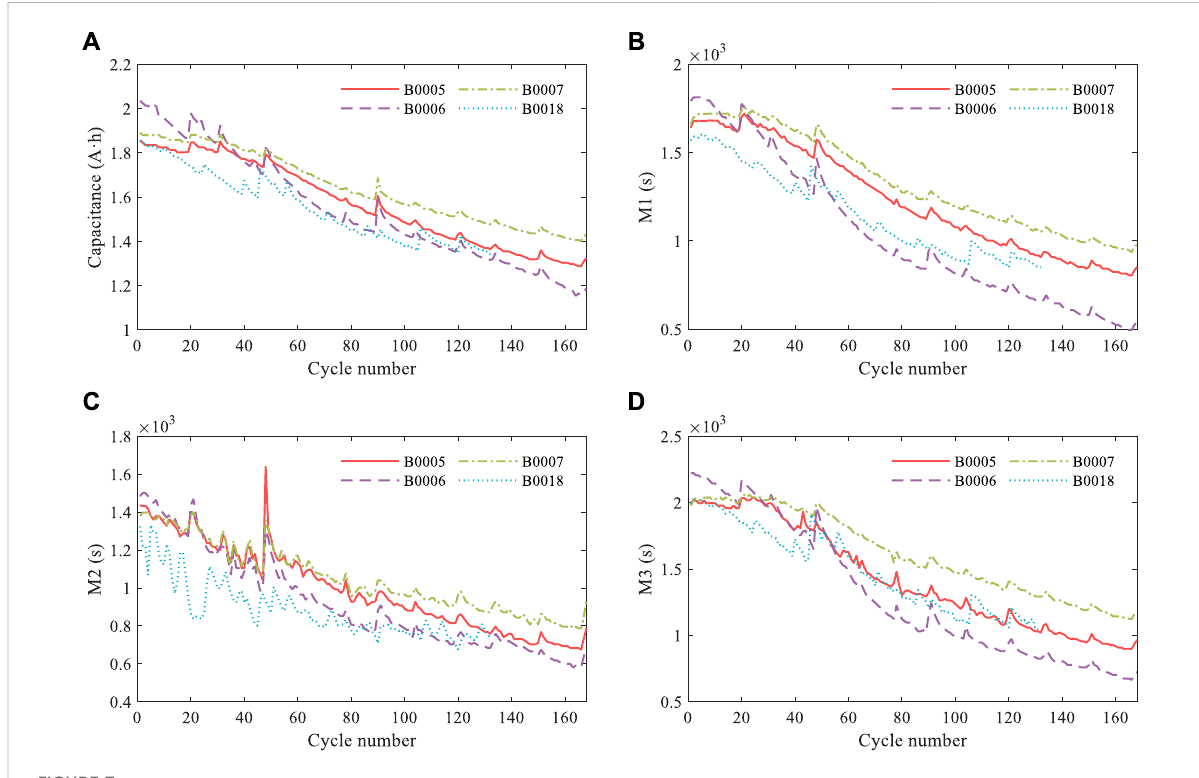
FIGURE 7 Health factor curve. (A) Variation of capacitance with the number of cycles. (B) Variation of health factor M1 with the number of cycles. (C) Variation of health factor M2 with the number of cycles. (D) Variation of health factor M3 with the number of cycles.